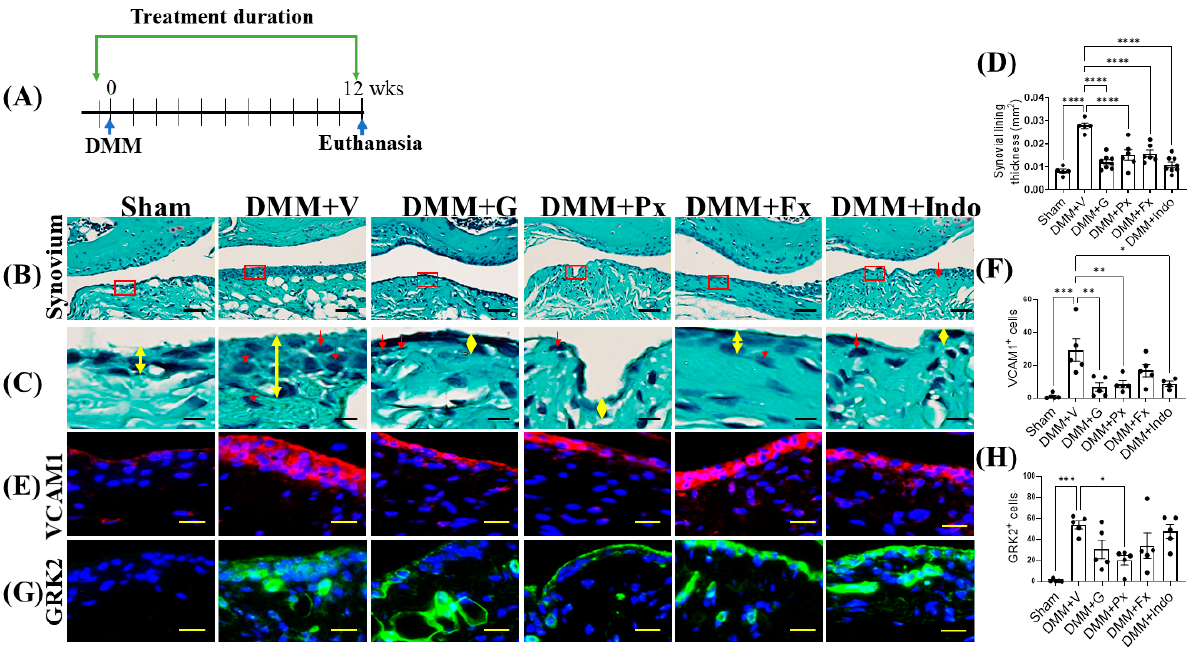
Figure 4. Early continuous G βγ -GRK2 inhibition attenuates synovitis in late-stage PTOA. ( A ) Schematic representation of timeline of drug treatment after sham ( n = 5) or DMM surgeries: Two days before surgery, mice started receiving daily intraperitoneal injections of vehicle (V; n = 5), gallein (G; 10 mg/kg per day, n = 7), paroxetine (Px; 5 mg/kg per day, n = 5), fluoxetine (Fx; 5 mg/kg per day, n = 6), or indomethacin (Indo; 2.5 mg/kg per day, n = 7). All mice were euthanized 12 weeks after surgery. Green arrows denote the duration of drug treatment. ( B ) Representative images of Safranin-O/Fast Green staining of the anterior femoral synovial region of mouse knee sections 12 weeks after DMM or sham surgery; scale bar, 50 µm. ( C ) Magnified images of regions indicated in red boxes in ( B ); scale bar, 10 µm. Yellow double-headed arrows depict synovial lining thickness, and red arrows indicate synovial inflammatory cells. ( D ) Quantification of anterior femoral synovial membrane thickness. Representative IF staining images in the anterior femoral synovium showing ( E ) VCAM1 (red) and ( G ) GRK2 (green). DAPI (blue) stains nuclei; scale bar, 50 µm. Quantification of the percentage of positive cells expressing ( F ) VCAM1 and ( H ) GRK2. n = 5 per group; * p < 0.05, ** p < 0.01, *** p < 0.001, and **** p < 0.0001 vs. DMM + V group using one-way ANOVA; values are expressed as means ± SEM.